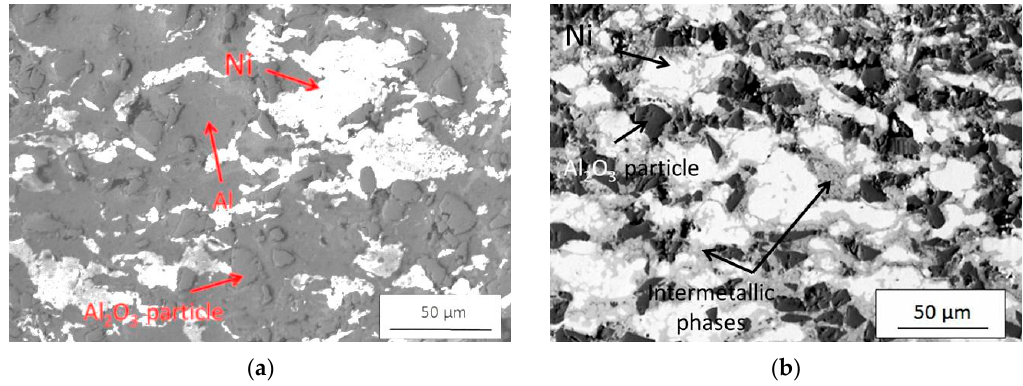
Figure 7. Micrographs (SEM, BSE) of 16% Al coating heated by resistance spot welding process with parameters No. 3 ( a ) and No. 4 ( b ).